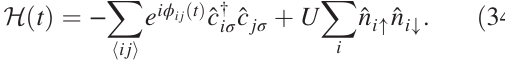
FIG. 18. Multipolar susceptibility of CeB 6 computed by DFT þ DMFT. (a) MPS, (b) bond dimensions along the MPS for ϵ ¼ 10 − 8 . In (b), the dashed line indicates the maximum bond dimensions in maximally entangled cases. The estimated com- pression ratio is around